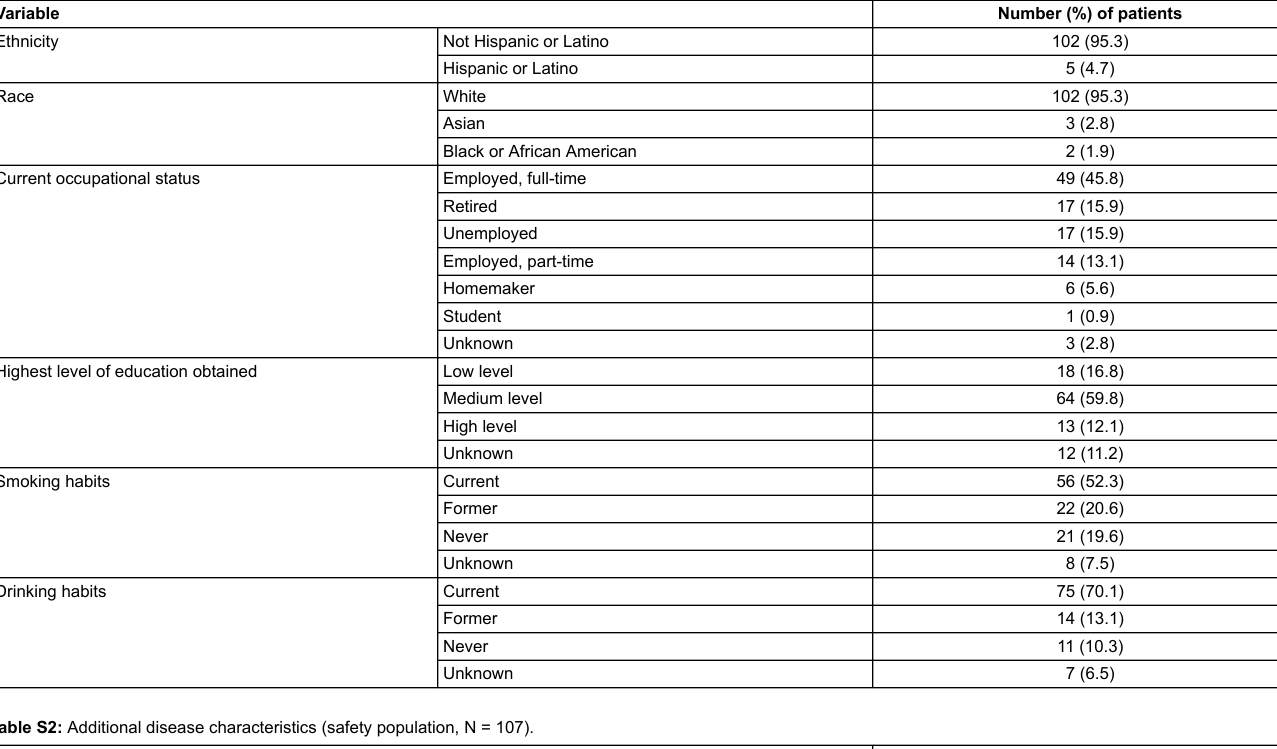
Table S1: Additional baseline demographic characteristics (safety population, N = 107).